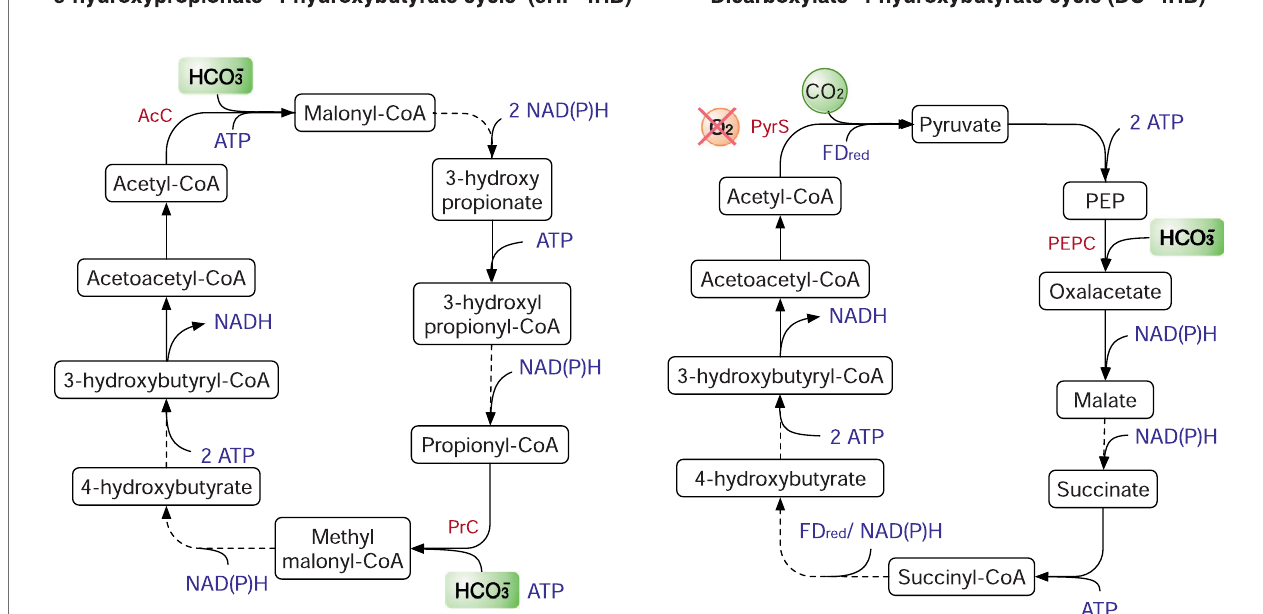
FIGURE 6 | The reductive glycine pathway (rGlyP). The rGlyP has two variants: serine deaminase pathway (in orange) and glycine reductase pathway (in black). Enzymes: FDH, ormatedehydrogenase; GCS, glycine cleavage/synthasesystem;GlyA,serinehydroxymethyltransferase;Sda, serine deaminase; GRC, Glycine reductase complex. Metabolites: THF, tetrahydrofolate.